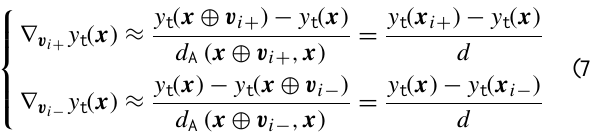
Fig. 3. Perturbation in the simplex of a composition x sampled from the texture triangle with indication of the directional vectors { v i + , v i − } , the perturbed compositions { x i + , x i − } , the bisectors B 1 , B 2 and B 3 and the translated bisectors B 0 1 , B 0 2 and B 0 3 ; illustration of compositional circles at different locations in the texture triangle.